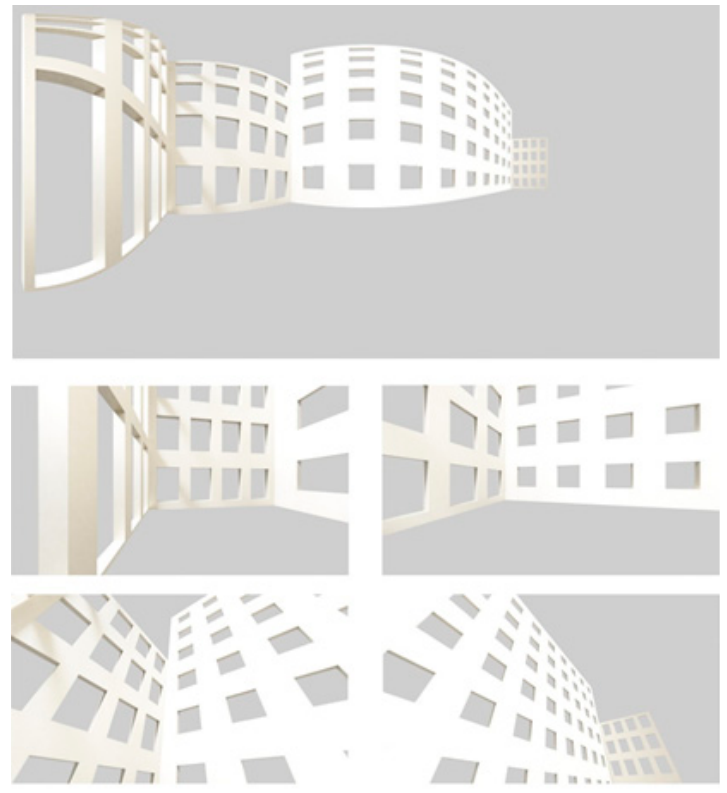
Figure 3. Four straight–linear perspectives calculated in GoPro ® VR player 3.0.5 software on the basis of a 360-degree spherical perspective image created with Blender ® 3.3.0 software.